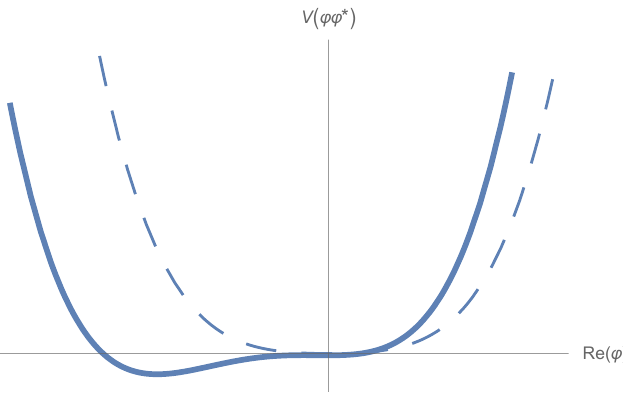
Figure 1 . Shown is the thermal scalar effective potential V ( ϕϕ ∗ ) for T < T H (dashed) and for T > T H (solid), as a function of Re ( ϕ ) with Im ( ϕ ) set to 0 . Below T H , both the mass term and the quartic coupling are positive. Above T H , the mass term is negative, leading to a mexican-hat tilted